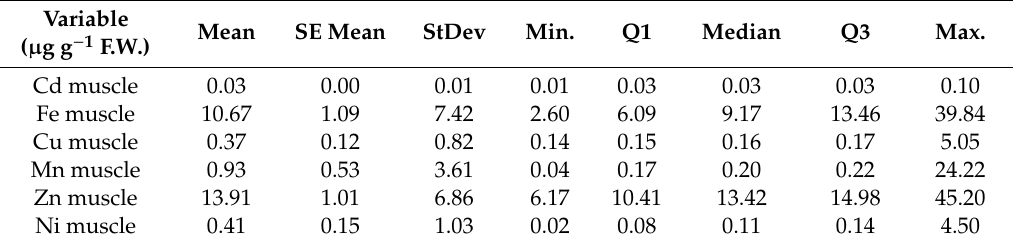
Table A6. Descriptive statistics of fourth group dataset.